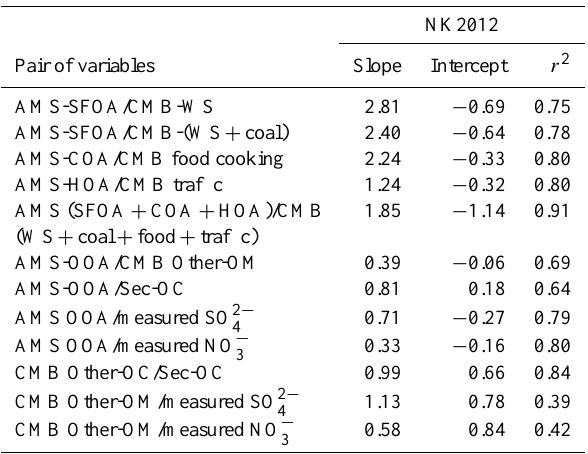
Table 5. RMA regression results for CMB and AMS-PMF organic matter estimates and related